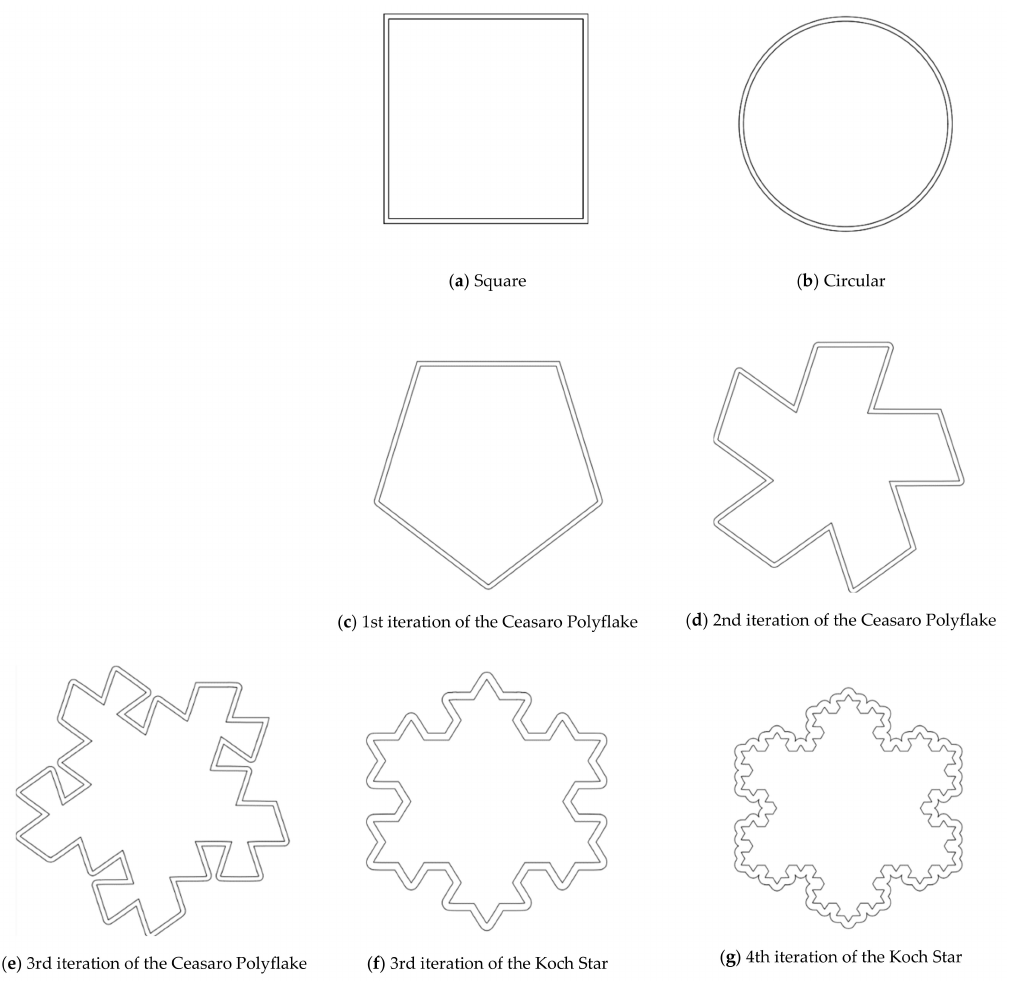
Figure 1. Cross-sections of 3D printed formworks. The ABS stay-in-place formworks were 3D printed in upright positions in groups of four. The nozzle used for 3D printing was characterized by the diameter of 0.8 mm. Two layers of filament were needed to create each formwork wall. The average printing speed of 30 mm/s was utilized to maintain the integrity of printed slender formworks and the best possible quality of the print. Altogether, 28 formworks were 3D printed. The formworks were sealed by a duct-tape from the bottom and filled with the fresh cement mortar mix from the top. In Figure 2, 3D printed formworks just after filling with the fresh cement mortar mix are presented. The formworks were covered from top by glass sheets and left for 28 days for curing in temperature of +20 ± 1 ◦ C. Before the tests, the duct-tape from the bottom parts of specimens was